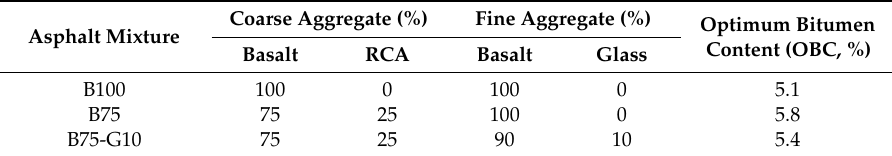
Table 9. Volumetric Properties of Asphalt Mixtures at Optimum Bitumen Content.